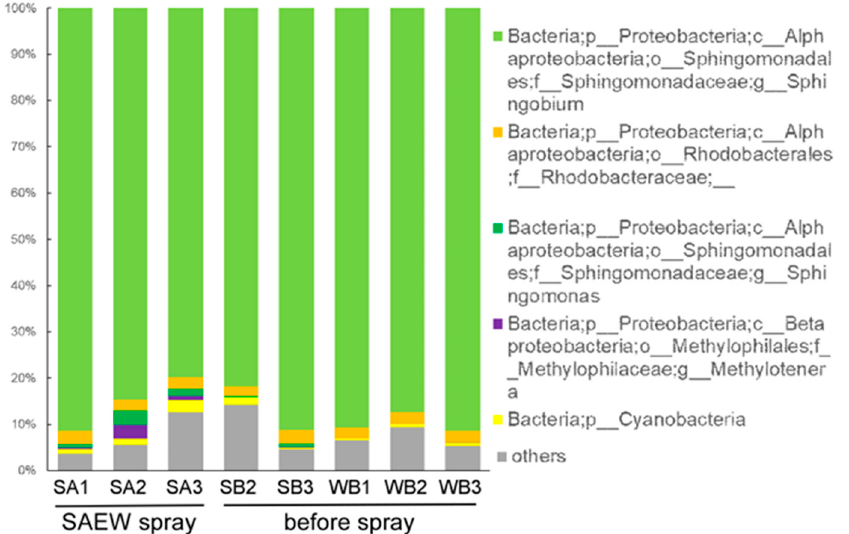
Figure 8. Taxonomic analysis of bacteria on the eggplant leaves. Leaf discs were taken from SB; area A before spray, WB; area B before spray, and SA; area A after SAEW spray.